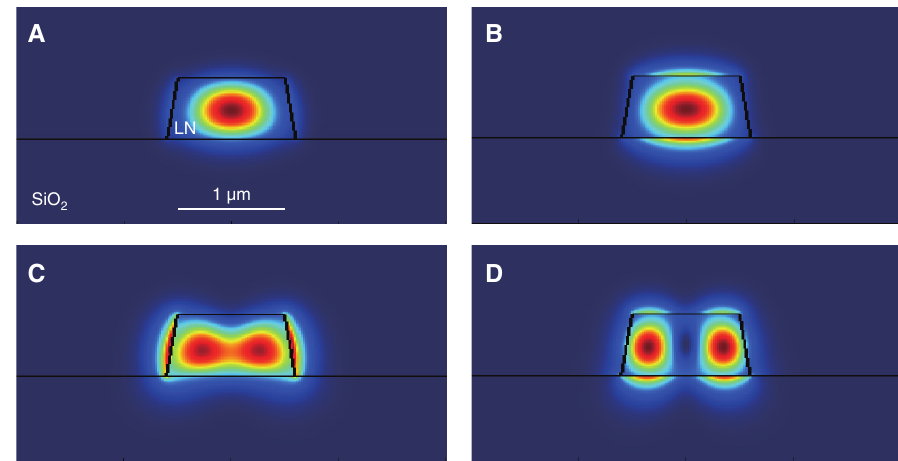
Figure 7: Calculated electric field intensity distribution of a direct etched LNOI waveguide with top width 1 μ m, height 600 nm and sidewall angle ~ 80 ° .